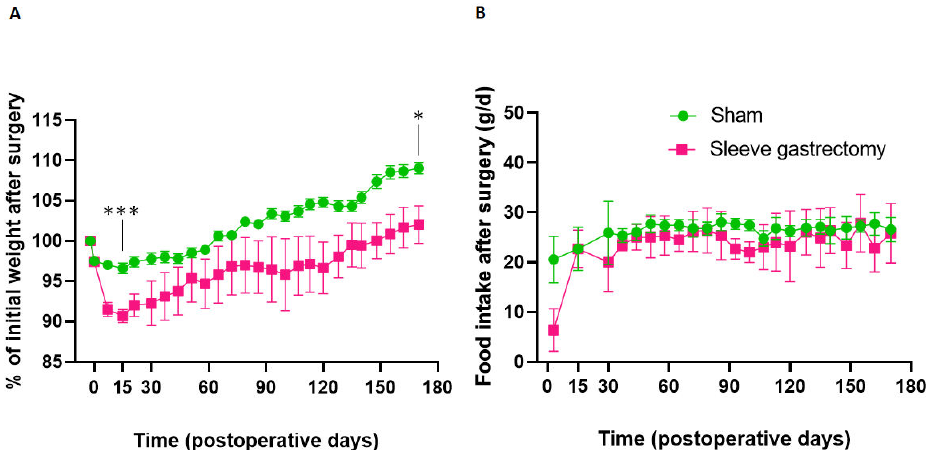
Figure 1. Body weight expressed as percent of preoperative weight ( A ) and daily food intake ( B ) in SG rats (n = 6) and sham rats (n = 8) during the 24 postoperative weeks. All values are expressed as means ± SEM, and comparisons between both groups were performed with Mann–Whitney tests after 2 weeks (maximal weight loss) and 24 weeks: * p < 0.5, *** p <